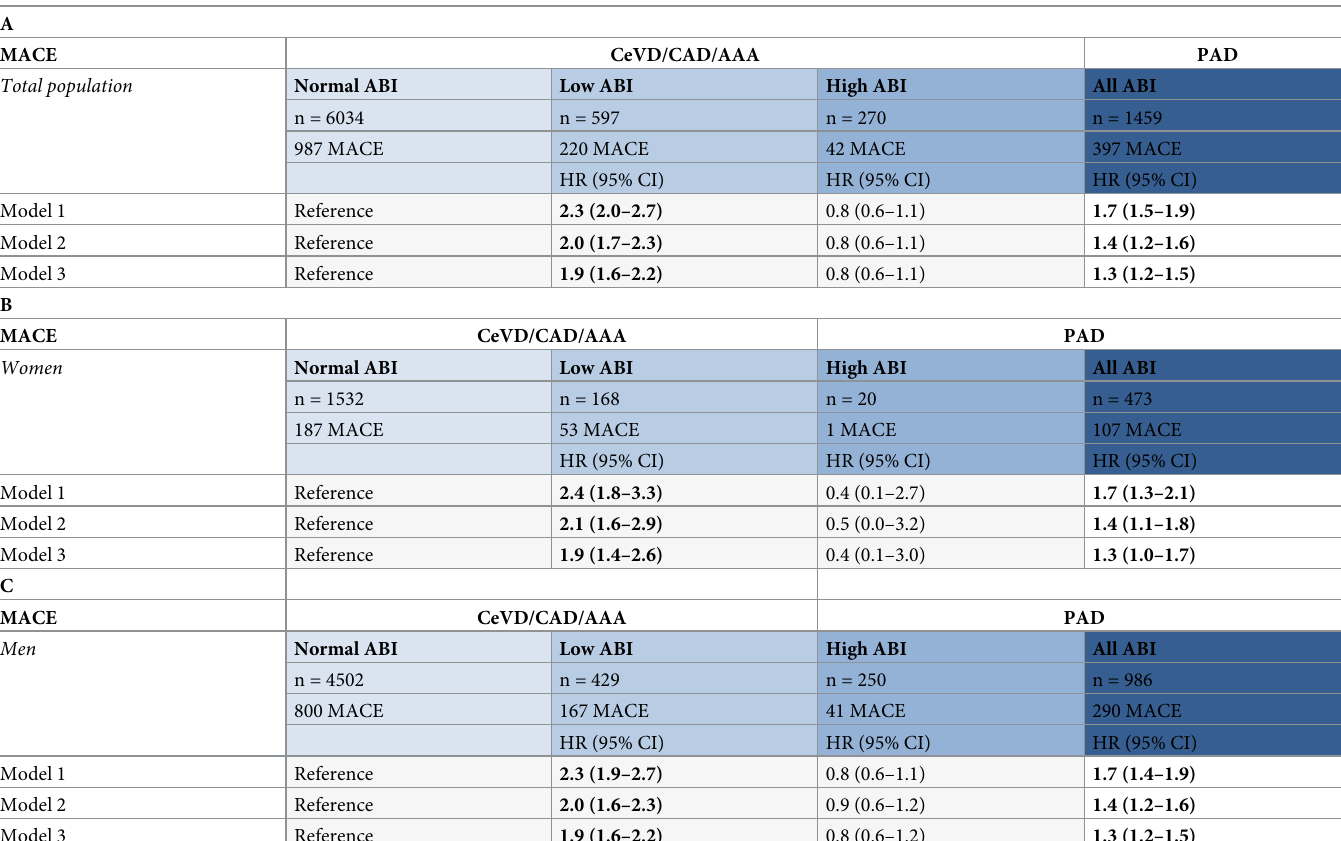
Table 3. The association between screen-detected abnormal ABI scores & manifest PAD and future MACE.